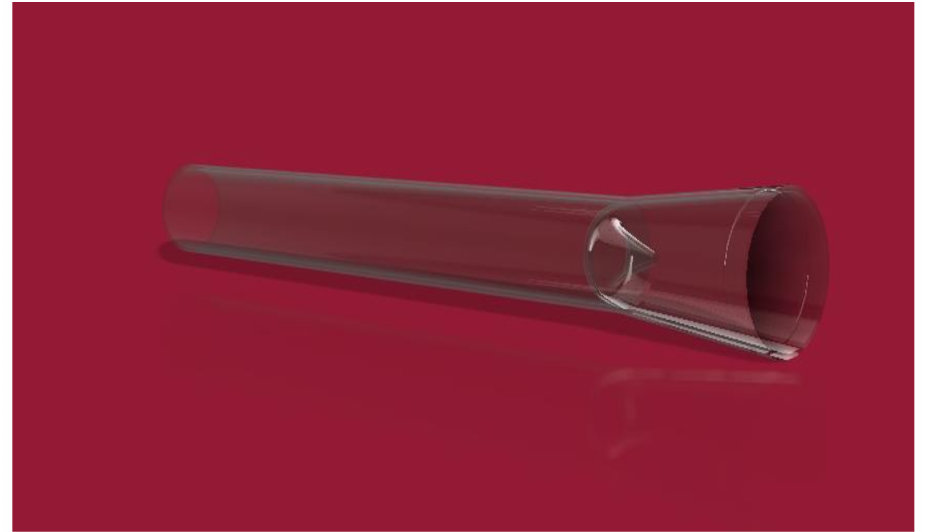
Figure 17. Final lymphatic vessel design